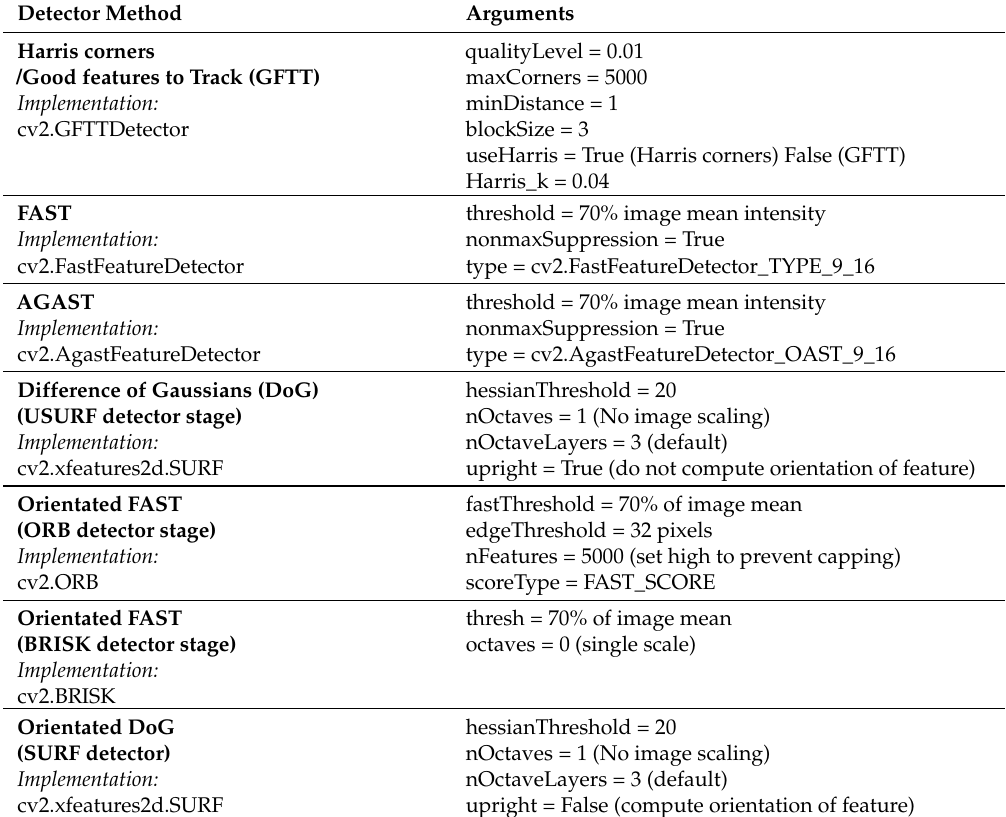
Table 1. Summary of feature detection methods, OpenCV python implementation, and parameters